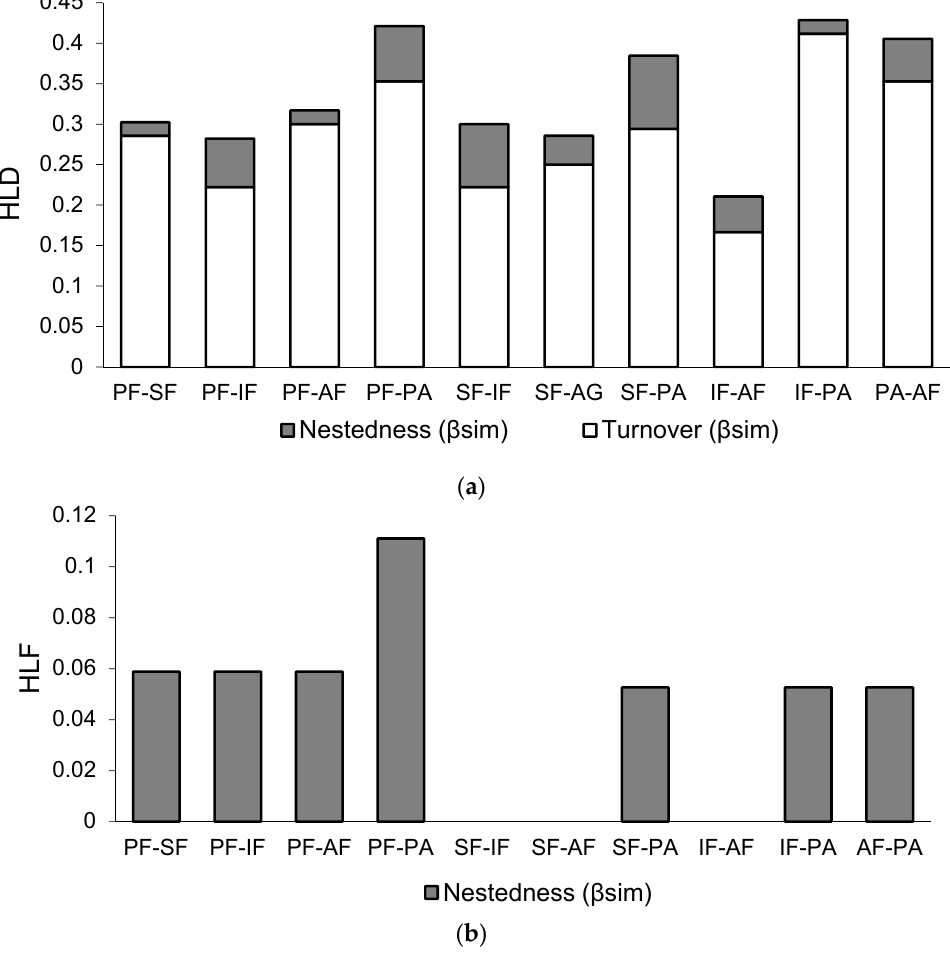
Figure 5. Spider assemblages’ dissimilarities between ecosystems (Beta diversity ( β sor), Turnover ( β sim), and Nestedness ( β nes)): ( a ) high-level diversity (HLD) dissimilarities; ( b ) high-level functionality (HLF) dissimilarities. Legend: Ecosystems: PF (Primary forest), SF (Secondary forest succession with 15 years of regeneration), IF (Incipient secondary succession forest with five years of regeneration), AF (Agroforestry cocoa plantations), PA (Pasture).